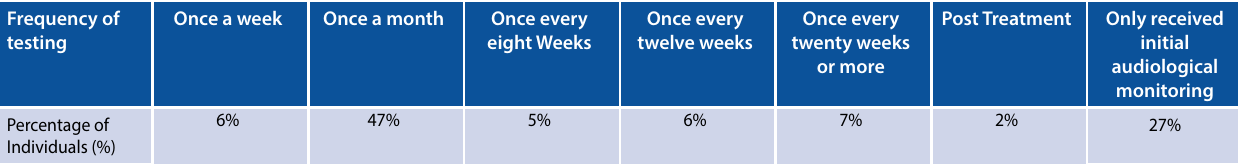
Table 4: Frequency of audiological monitoring ( n = 124) Frequency of testing